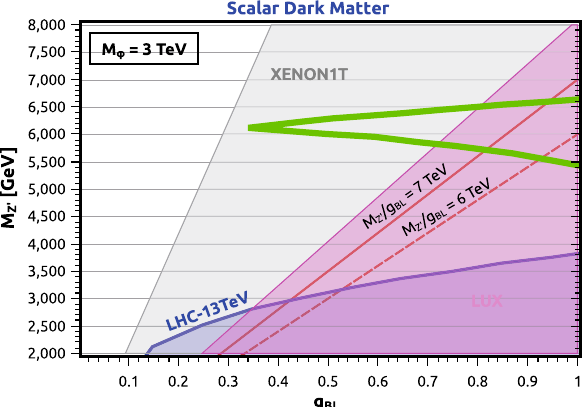
Fig. 14 Allowed region of parameters for a 3 TeV scalar field as dark matter. The green curve delimits the region of parameter space with the right abundance ( (cid:2) h 2 = 0 . 11 − 0 . 12), the pink ( gray ) shaded region is ruled out by LUX2016 (XENON1T), the blue region is excluded by dilepton data from the LHC, and the solid red ( dashed ) lines rep- resent the current (old) LEP-II bounds, namely M Z (cid:2) / g BL > 7 TeV ( M Z (cid:2) / g BL > 6